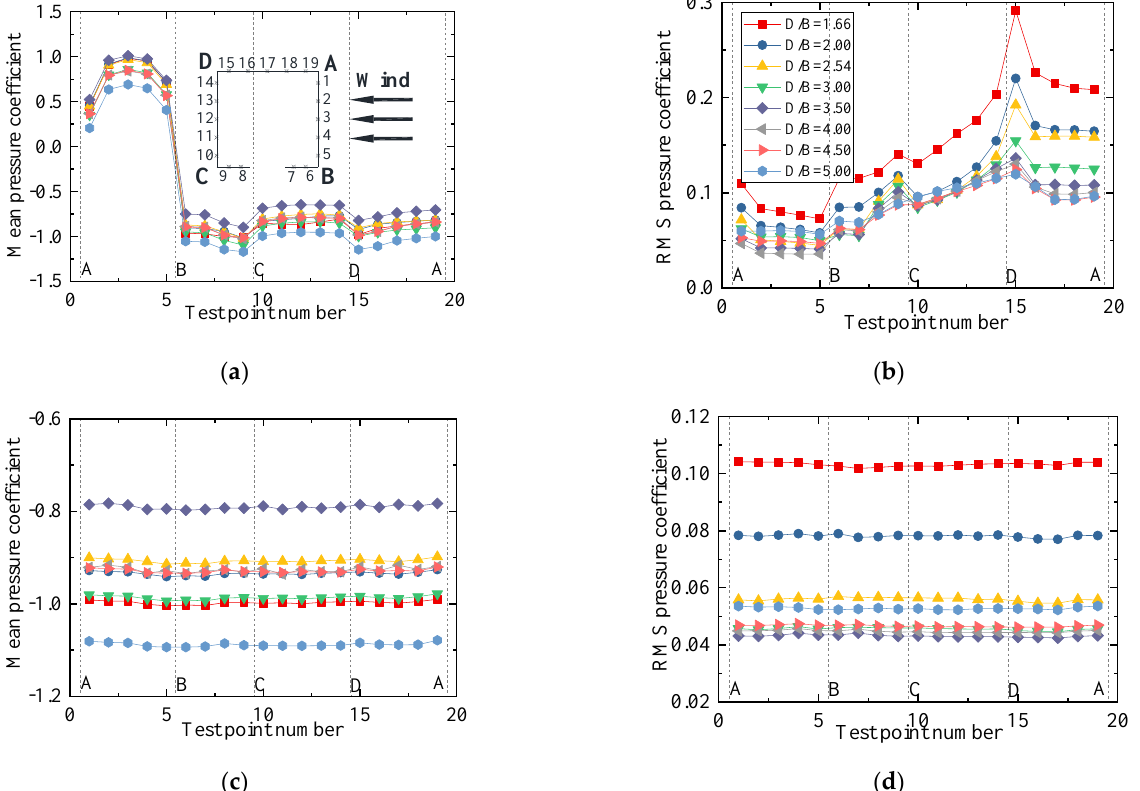
Figure 18. Wind pressure coefficient of the upstream bridge for Case 3: ( a ) Mean values of the outer taps; ( b ) RMS values of the outer taps; ( c ) Mean values of the inner taps; ( d ) RMS values of the inner taps.